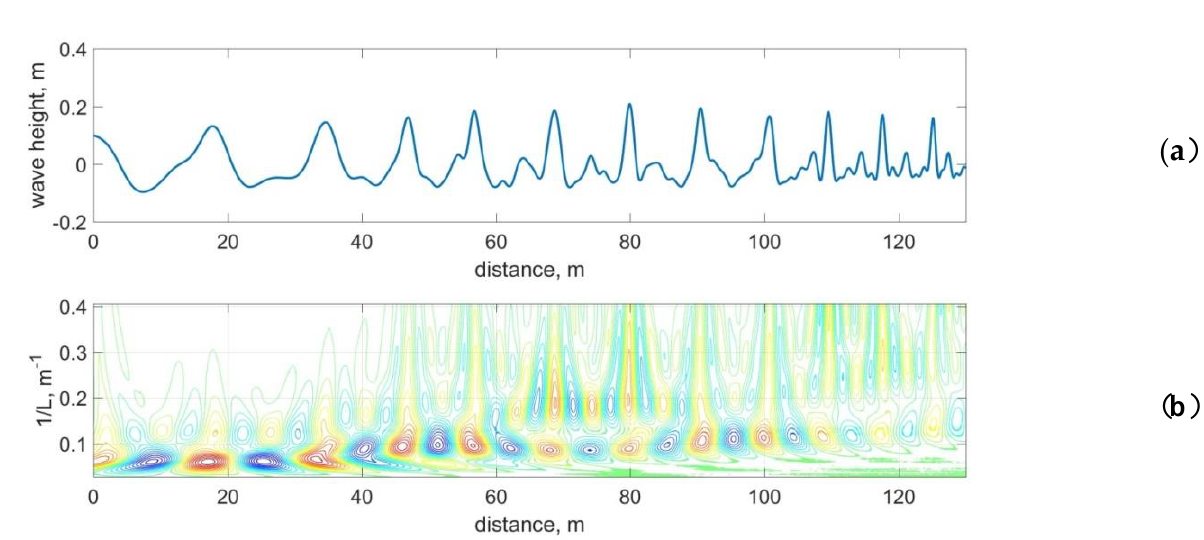
Figure 3. Spatial evolution of initially monochromatic wave ( a ) and its wavelet transform ( b ) modelled for the bottom relief in Figure 2b. Wavelet coefficients are shown by the intensity of the color from dark blue (minimum) to dark red